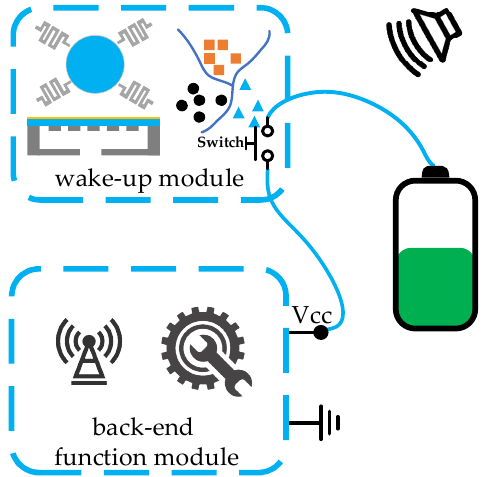
Figure 22. Architecture 4: zero-power recognition and zero-power sleep.